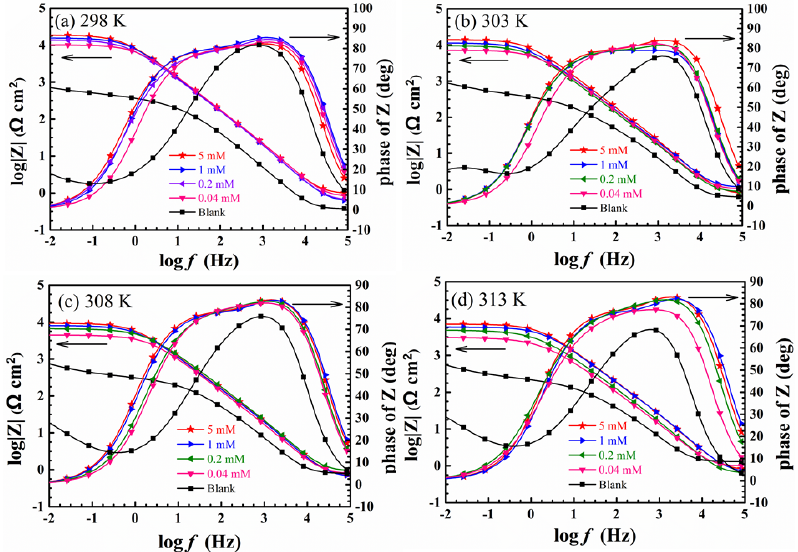
Figure 5. Bode plots of copper present and lacking itraconazole at various temperatures in 0.5 M H 2 SO 4 : ( a ) 298 K, ( b ) 303 K, ( c ) 308 K, and ( d ) 313 K.